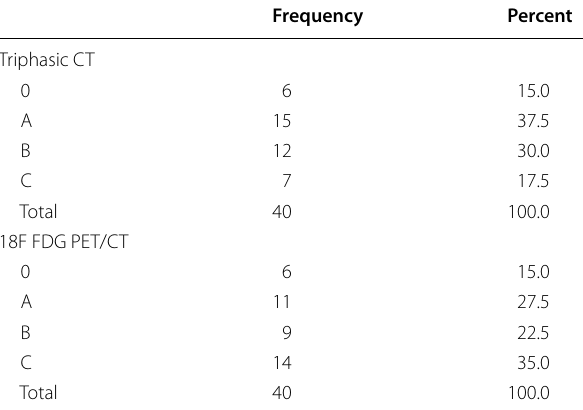
Table 2 18F FDG PET/CT versus triphasic CT regarding BCLC Staging of HCCs